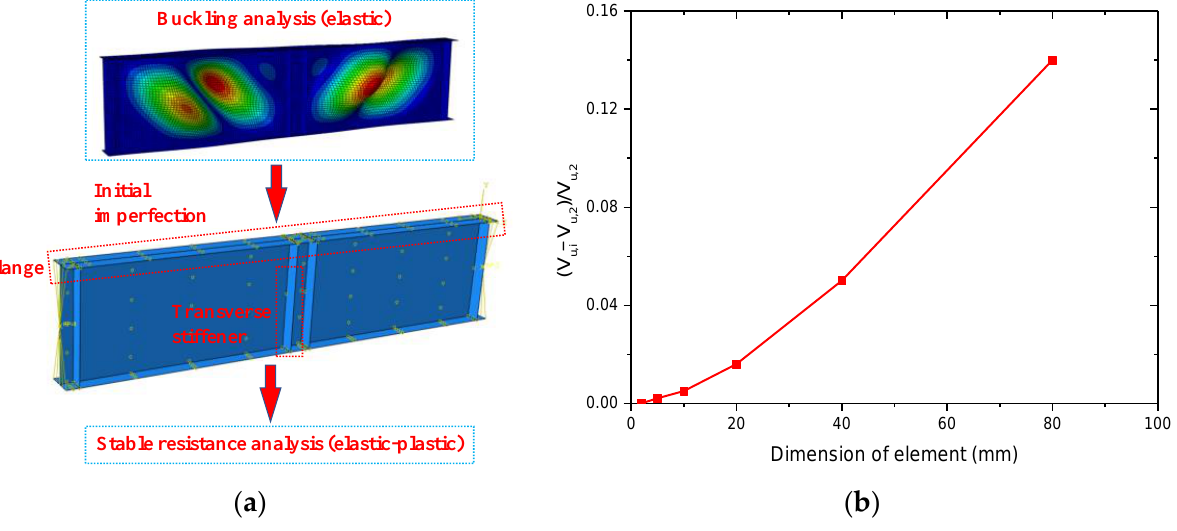
Figure 5. Numerical analysis. ( a ) FE model ; ( b ) convergence study .